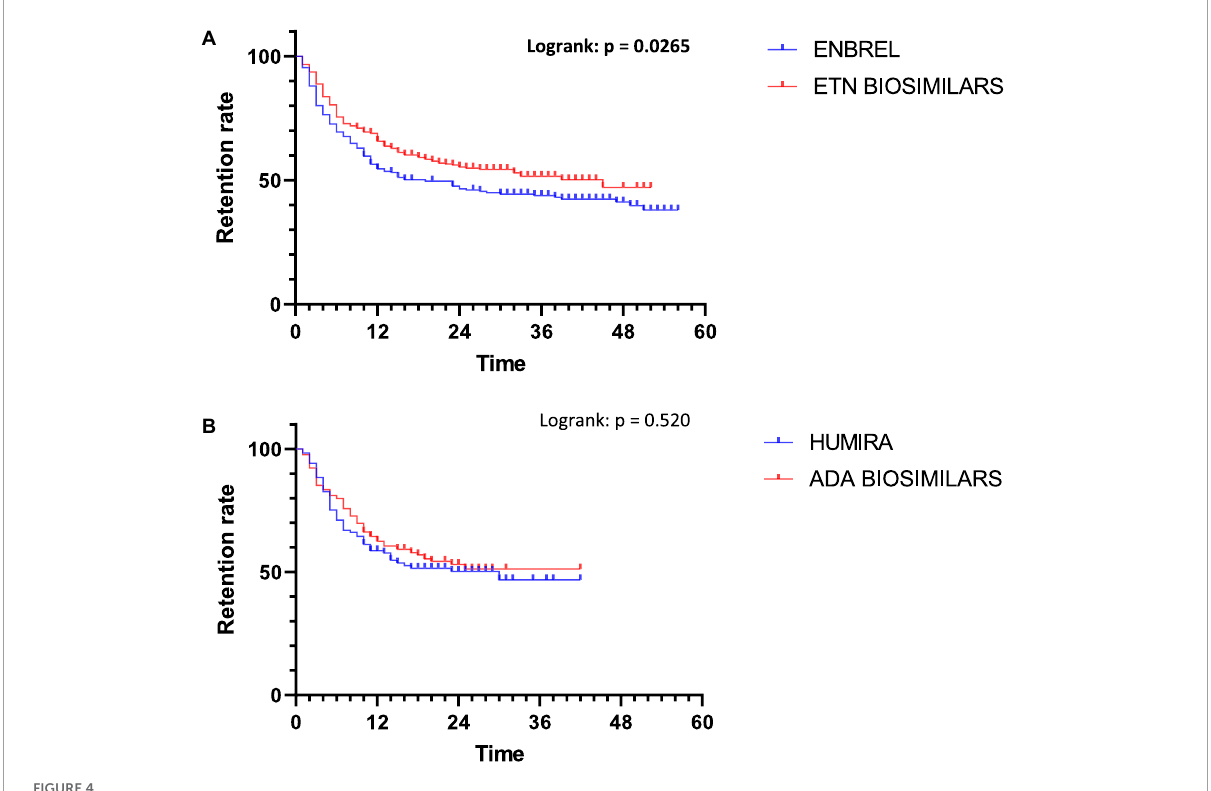
FIGURE4 Comparison of bsDMARD and boDMARD retention for ETN (A) and ADA (B)